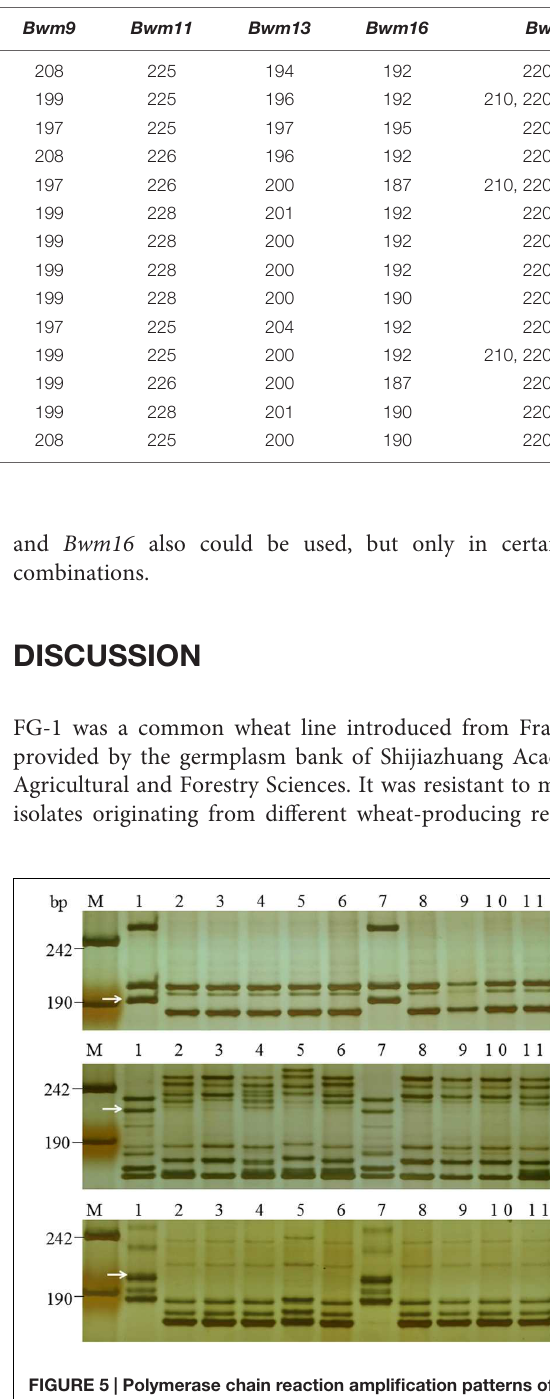
FIGURE 5 | Polymerase chain reaction amplification patterns of PmFG -linked SNP-derived markers Bwm20 (A), Bwm21 (B), and Bwm25 (C) in FG-1, Mingxian 169 and several wheat cultivars. M, DNA marker pUC18 Msp I; lanes 1 and 2, FG-1 and Mingxian 169; lanes 3–12, wheat cultivars with sequential order of Yumai 13, Lumai 1, Xiaoyan 6, Jimai 19, Jimai 22, Yangmai 158, Yumai 18, Zhengmai 9023, Yumai 34, and Lumai 14. The white arrows indicate the 195, 220, and 208 bp polymorphic bands in